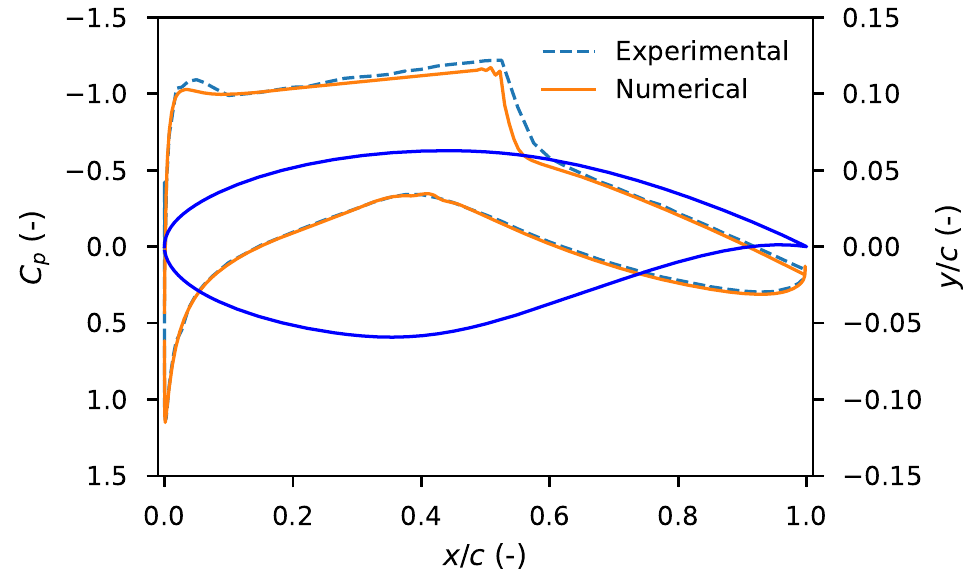
Figure 6. Comparison of the computational pressure coefficient distribution with the experimental one from [36].